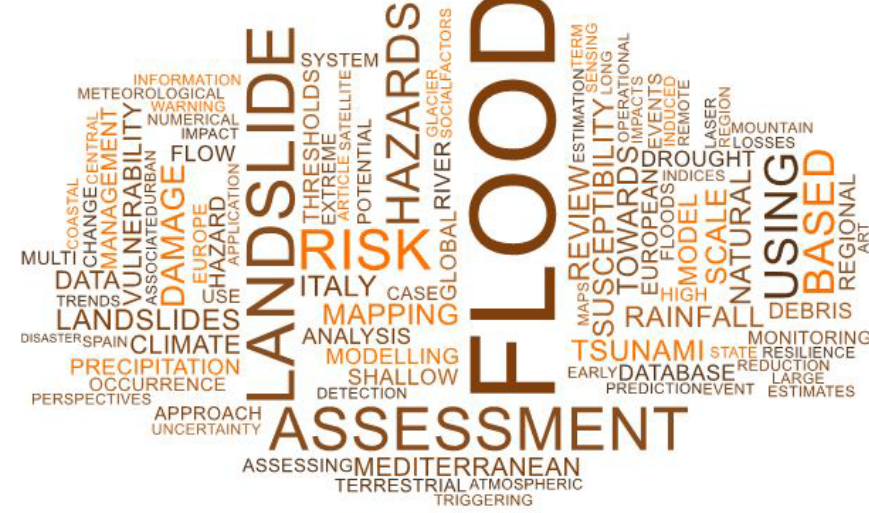
Figure 1. Word cloud based on the titles of all published articles in Natural Hazards and Earth System Sciences in the last 20 years. Table 1. Representation of the NHESS topics by the selected articles. Topics of the